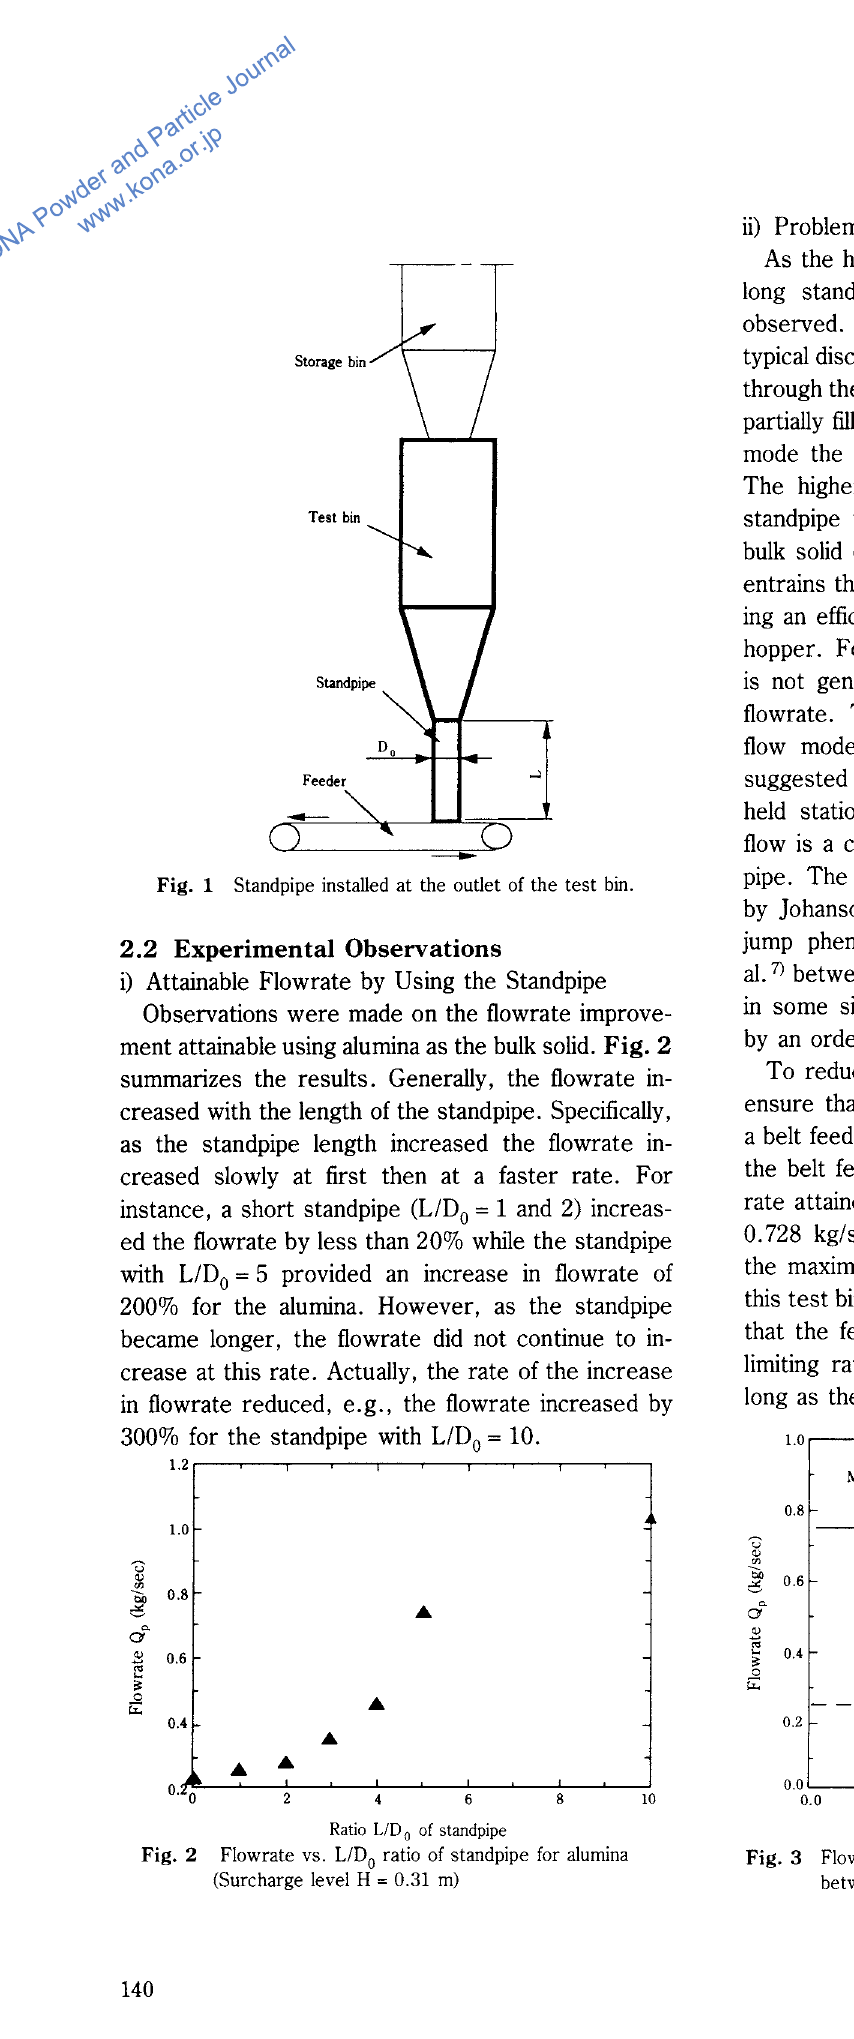
ratio of standpipe for alumina Fig. 2 Flowrate vs. LID 0 (Surcharge level H = 0.31